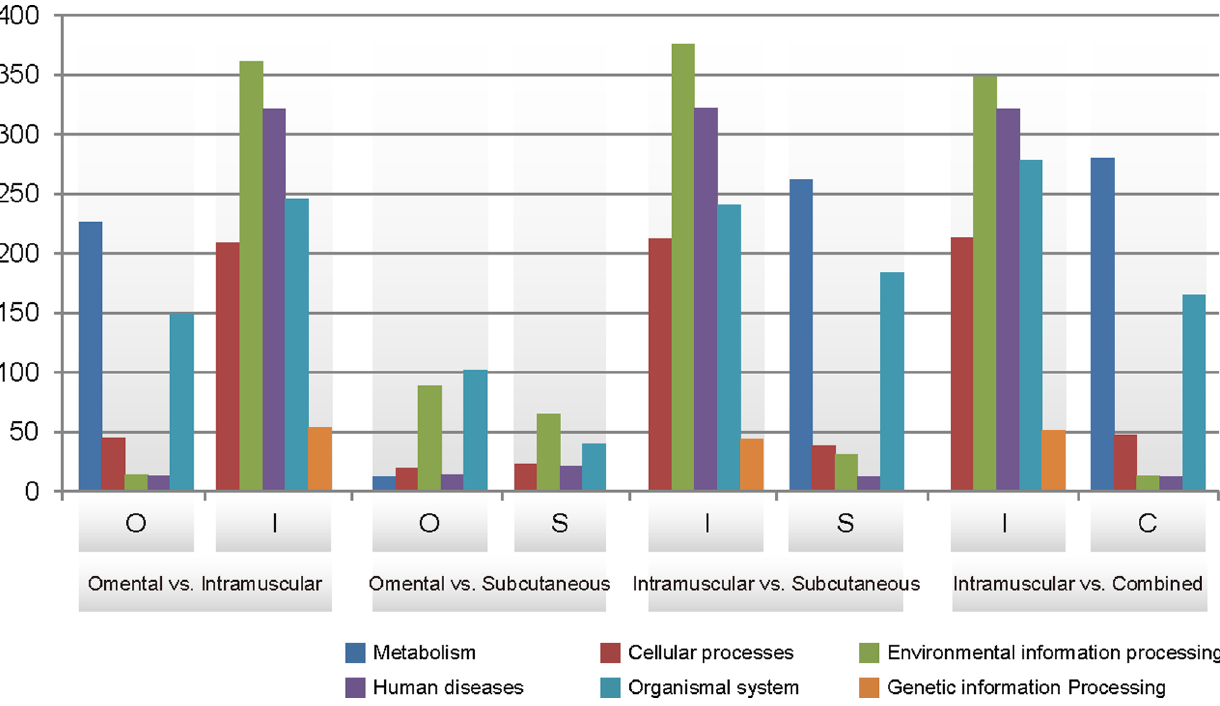
Figure 4. Representative KEGG pathways of DEGs resulted from the pairwise comparison among different adipose depots. Y-axis shows the number of gene